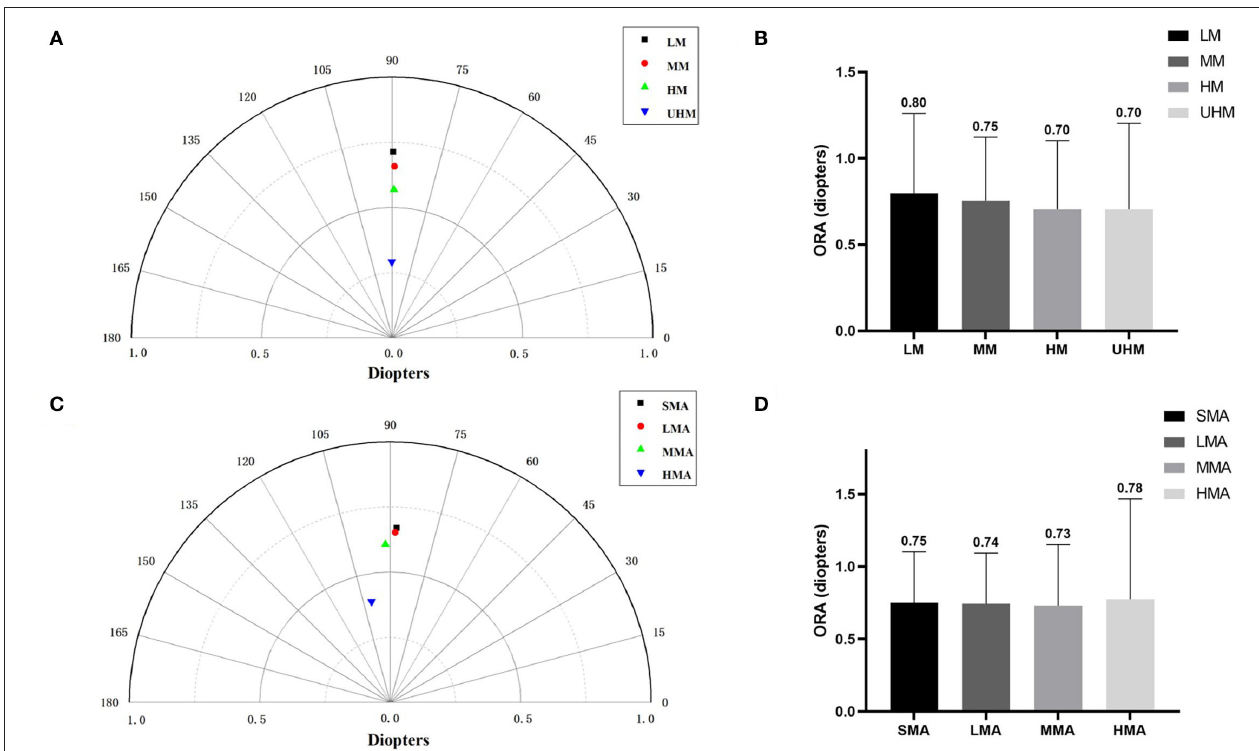
FIGURE 3 | (A) The summated vector mean of ocular residual astigmatism (ORA) in different myopia groups. (B) The mean magnitude of ORA in different myopia groups. (C) The summated vector mean of ORA in different astigmatism groups. (D) The mean magnitude of ORA in different astigmatism groups.